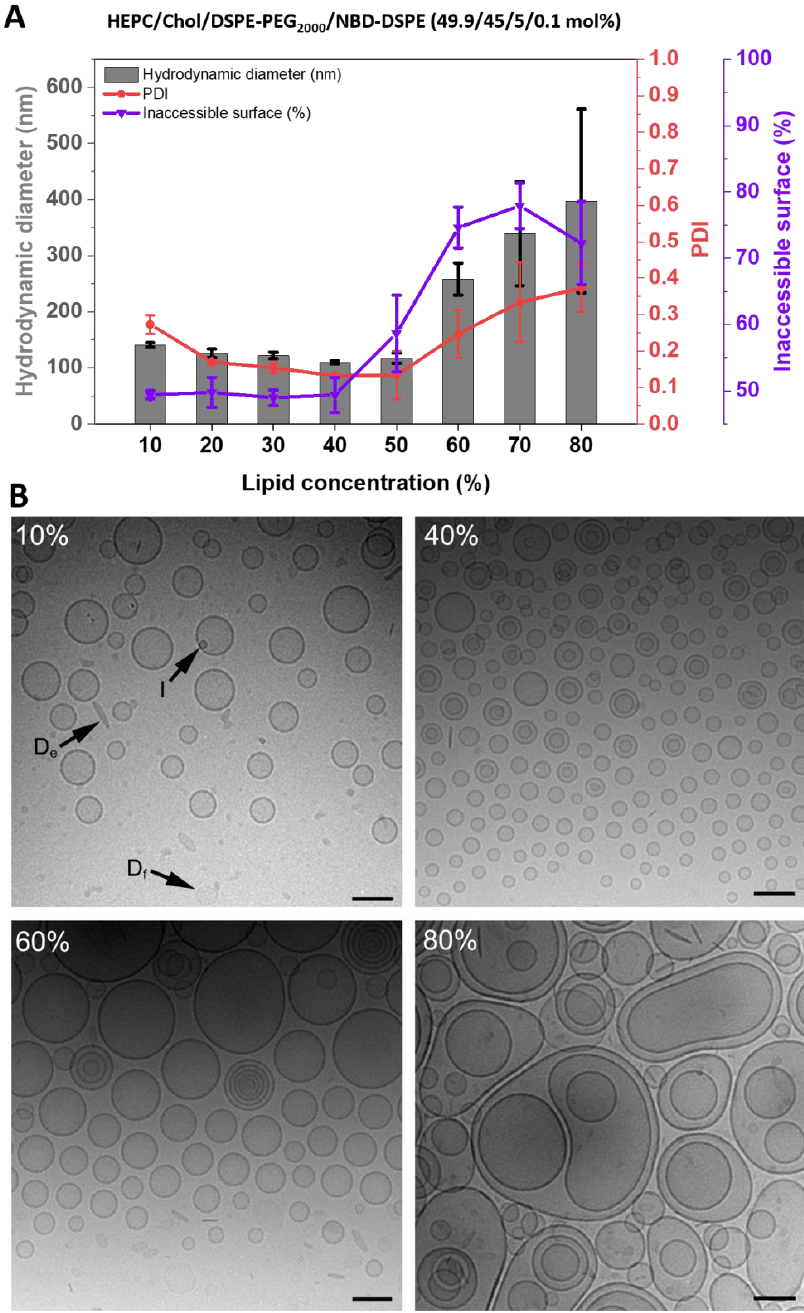
Figure 3. ( A ): Inaccessible surface, hydrodynamic diameter, and PDI depending on the lipid concentration used for the DC-homogenization of HEPC/Chol/DSPE-PEG 2000 /NBD-DSPE 49.9/45/5/0.1) (mol%) lipid/buffer mixture. The resulting liposomes were measured by fluorescence-based IAS assay and DLS. Liposomes were prepared by DC at 2350 rpm, for 30 min, and at 20 °C, and redispersed by DC at 1500 rpm, for 2 min, and at 20 °C with TRIS buffer. Data are shown as the mean ± SD (n = 3). ( B ): Cryo-EM images of HEPC/Chol/DSPE-PEG 2000 50/45/5 (mol%) liposomes prepared by DC at 10%, 40%, 60%, and 80% lipid concentrations (VPG). Arrows denoted (D e ) indicate lipodisks viewed edge-on and lipodisks viewed face-on (D f ); (I) indicates ice crystals. Scale bar = 100 nm.